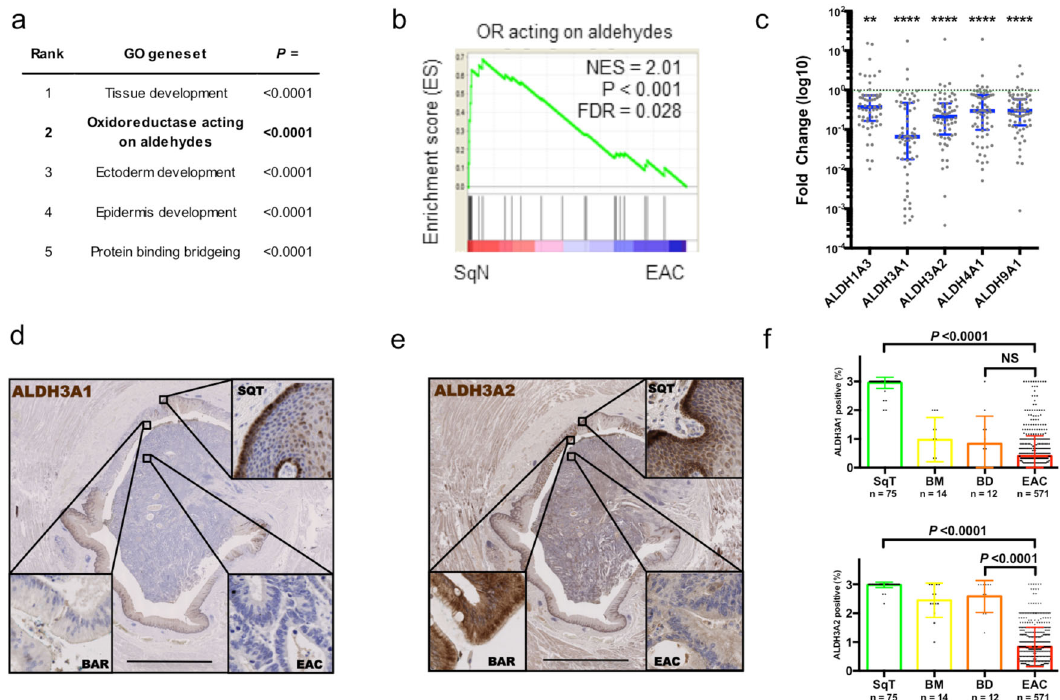
Fig. 1 Loss of aldehyde detoxi fi cation is conspicuous in esophageal adenocarcinoma. a Geneset enrichment analysis comparing squamous mucosa (SqN, n = 19) and esophageal adenocarcinoma (EAC, n = 21) samples in GSE26886. Five most signi fi cantly enriched Gene Ontology v4.0 genesets in squamous mucosa. P values calculated by the permutation test in the GSEA analysis. b Enrichment plot of “ oxidoreductase (OR) acting on aldehydes ” geneset from a . c Relative expression of candidate ALDH isoenzymes in EAC endoscopic biopsies compared to paired SqT biopsies ( n = 67), quantitative reverse transcriptase polymerase chain reaction (median and 95% con fi dence interval provided. P values calculated with two-sided Wilcoxon matched-pairs signed rank test; ALDH1A3 P = 0.0026, all others P < 0.0001). d , e Representative immunostaining for ALDH3A1 ( d ) and ALDH3A2 ( e ) in an esophageal cross-section featuring an adenocarcinoma (bar indicates 5 mm). f Summary of ALDH3A1 and -3A2 immunostaining in cancer-adjacent squamous tissue (SqT, n = 75), Barrett ’ s metaplasia (BM, n = 14); Barrett ’ s dysplasia (BD, n = 12), and EAC ( n = 571) drawn from nine UK hospitals. Mean ± SEM provided, Kruskall – Wallis test with Dunn ’ s correction ** P < 0.01, **** P < 0.0001. Source data are provided in the Source Data fi